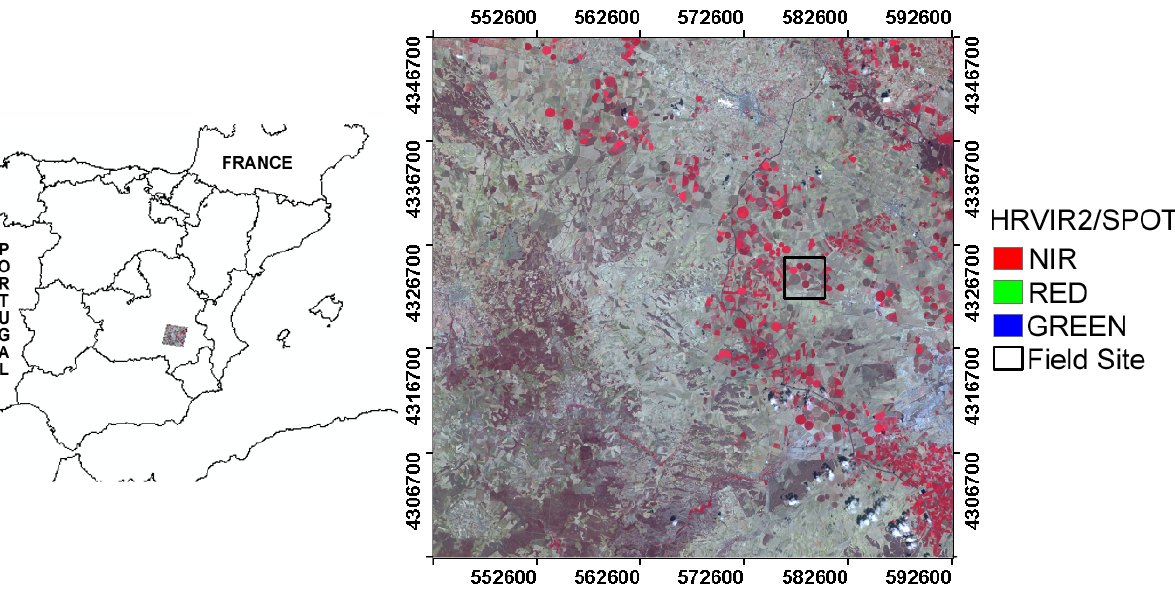
Figure 1. Experiment site location over a HRVIR2/SPOT4 scene (black box on the SPOT scene). The background image consists of a RGB (NIR, RED, GREEN) color composite SPOT image acquired on July 3th,